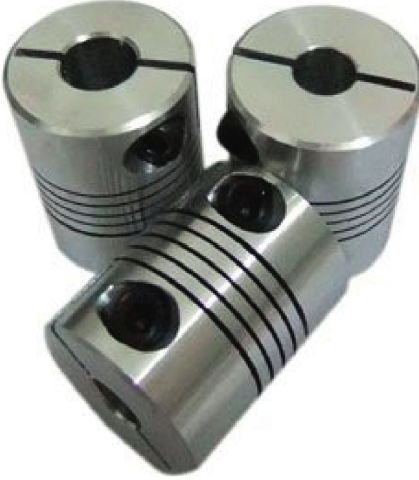
Figure 5: The flexible spiral couplings used in this